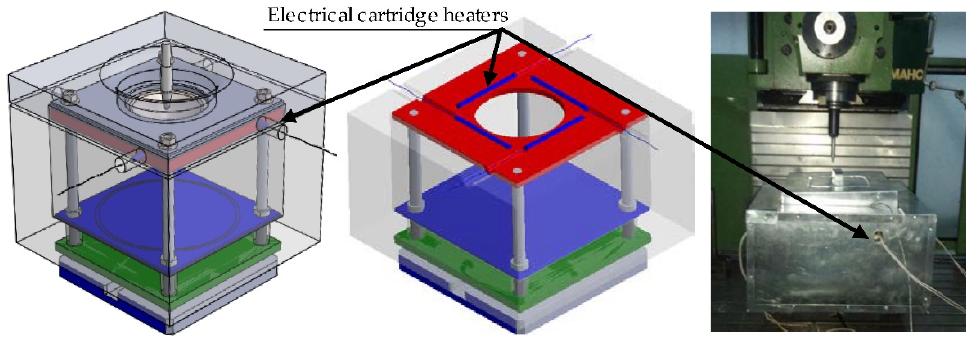
Figure 1. Warm incremental sheet-forming setup with cartridge heaters.